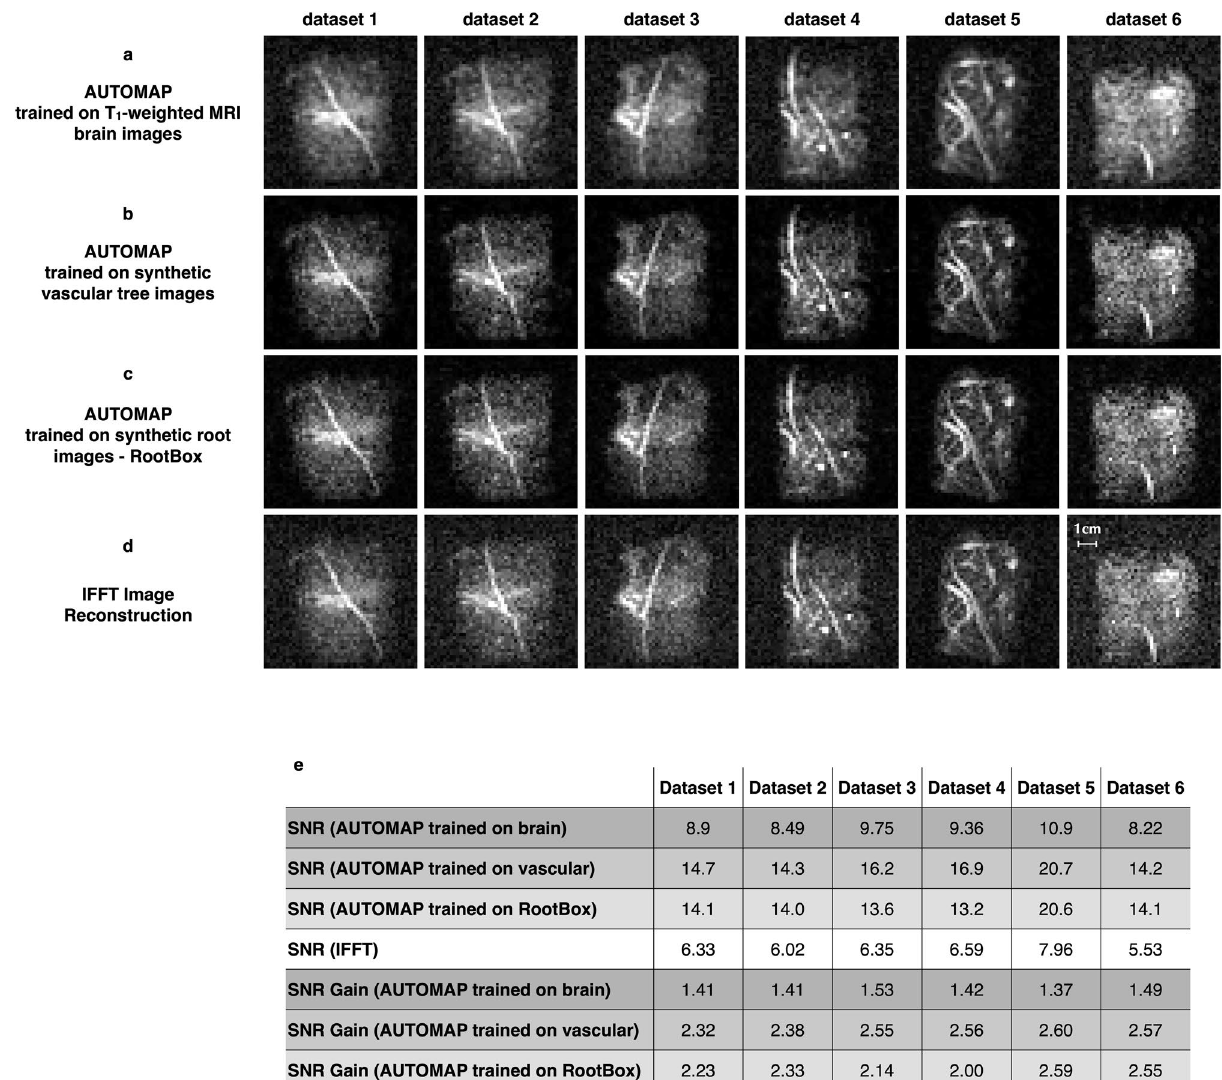
Figure 7. Reconstruction of sorghum dataset acquired at 47 mT using AUTOMAP trained either on T 1 - weighted MRI brain images, synthetic vascular tree Images, or synthetic root images. Six 2D projections of roots images (labelled dataset 1–6) extracted from six different roots’ samples are shown. All the 48 × 48 datasets were acquired at 47 mT. In the upper panel ( a ), the raw data were reconstructed with AUTOMAP trained on T 1 -weighted MRI brain images, the panel ( b ) are the same datasets reconstructed with AUTOMAP trained on synthetic Vascular Tree Images and finally the same datasets were reconstructed with AUTOMAP trained on synthetic root images in panel ( c ). The lower panel ( d ) shows the images reconstructed with the standard IFFT method. All the images were windowed to the same level for comparison. The scale of 1 cm represented one of the images is the same for all the 2D projections. ( e ) The table summarizes the mean SNR analysis of the 2D projections of the roots 48 × 48 datasets acquired at 47 increase in the PSNR (data not shown). However, the addition of random white Gaussian noise (15–35 dB) in each k- space data in the training database shows a further improvement in the output images with significant noise reduction. As per the SSIM values, we did not observe any loss of information compared to the reference image dataset. State-of-the-art denoising methods like BM3D 17 , WNNM 22 or TNRD 23 which are based on nonlocal self- similarity image prior models are popular and effective denoisers that generally act on the reconstructed mag- nitude images. However, these approaches typically employ time-consuming iterative optimizations that suffer from generalization to multiple noise levels. Zhang et al. proposed a deep convolutional neural network denoising (DnCNN) approach that uses a residual network architecture to learn the noise and subtract it from the image. This work showed that the state-of-the BM3D with collaborative filtering as well as the DnCNN approach can attenuate the additive white Gaussian noise operating purely on the image (magnitude) data for a range of noise levels, and that DnCNN has been evaluated as one of the standard machine learning methods to denoising